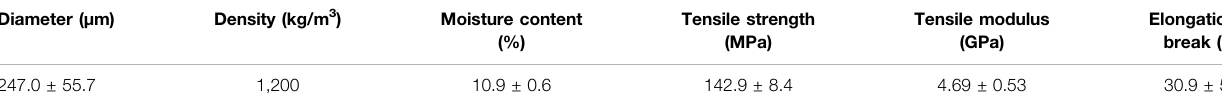
TABLE 4 | Coconut fi ber